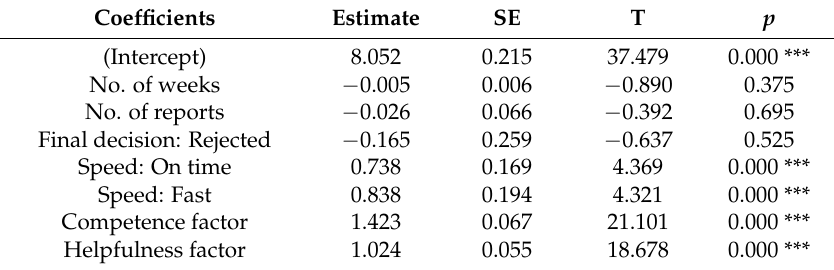
Table 4. Ordinary Least Squares (OLS) estimation of factors predicting authors’ assessment of reviewers’ work. Reference classes were “accepted” for the final decision and “slow” for the speed of review.